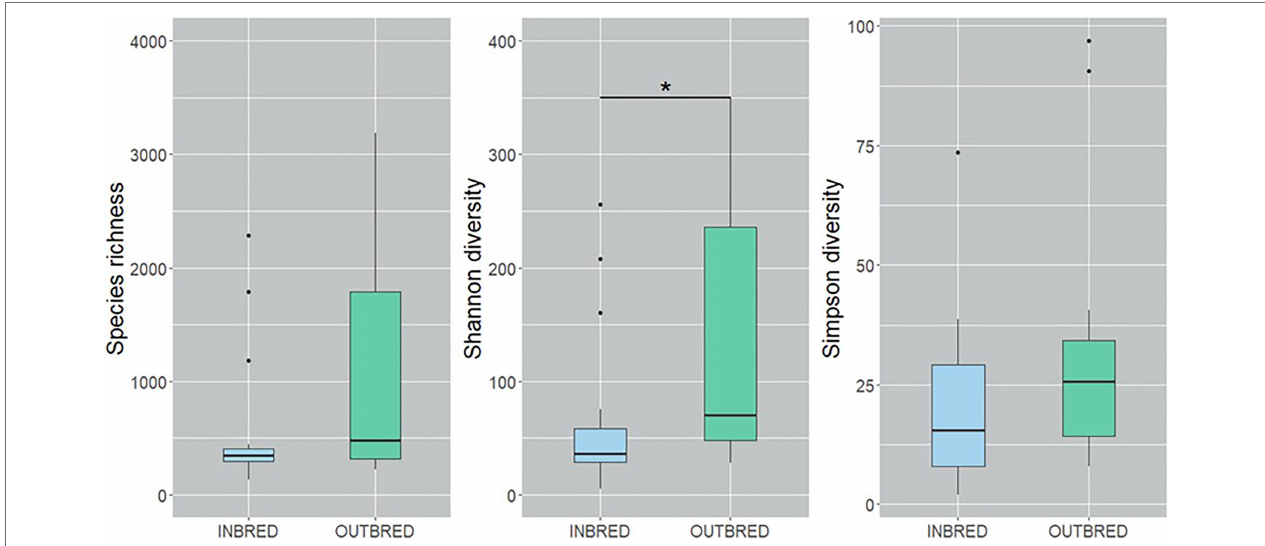
FIGURE 2 | Alpha diversity of the bacteria in the mouth of the inbred and outbred groups of Nile tilapia. Species richness of the groups is not significantly different. Shannon diversity is higher in the outbred group ( p = 0.007, indicated with an asterisk). Simpson diversity indicated an increasing trend in the dominant ASVs of the outbred group ( p = 0.08). The boxplots show minimum, lower quartile, median, upper quartile and maximum